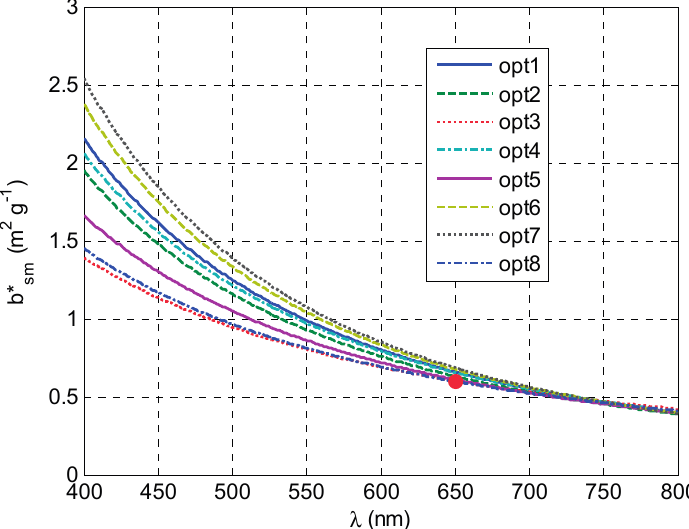
( λ ) for each optimization, corresponding to the columns of Figure 7. Retrieved b* sm Table 2. The red dot corresponds to the predicted value by Equation